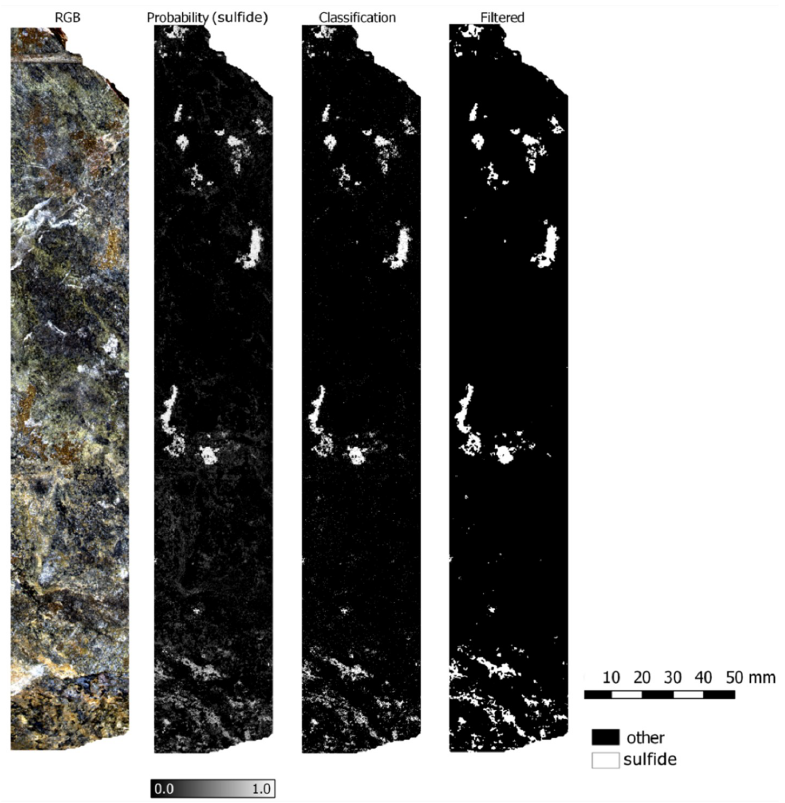
Figure 1. Example of red-green-blue (RGB) image, sulfide class membership probability, sulfide classifications and filtered sulfide classifications for drill core sample 12.